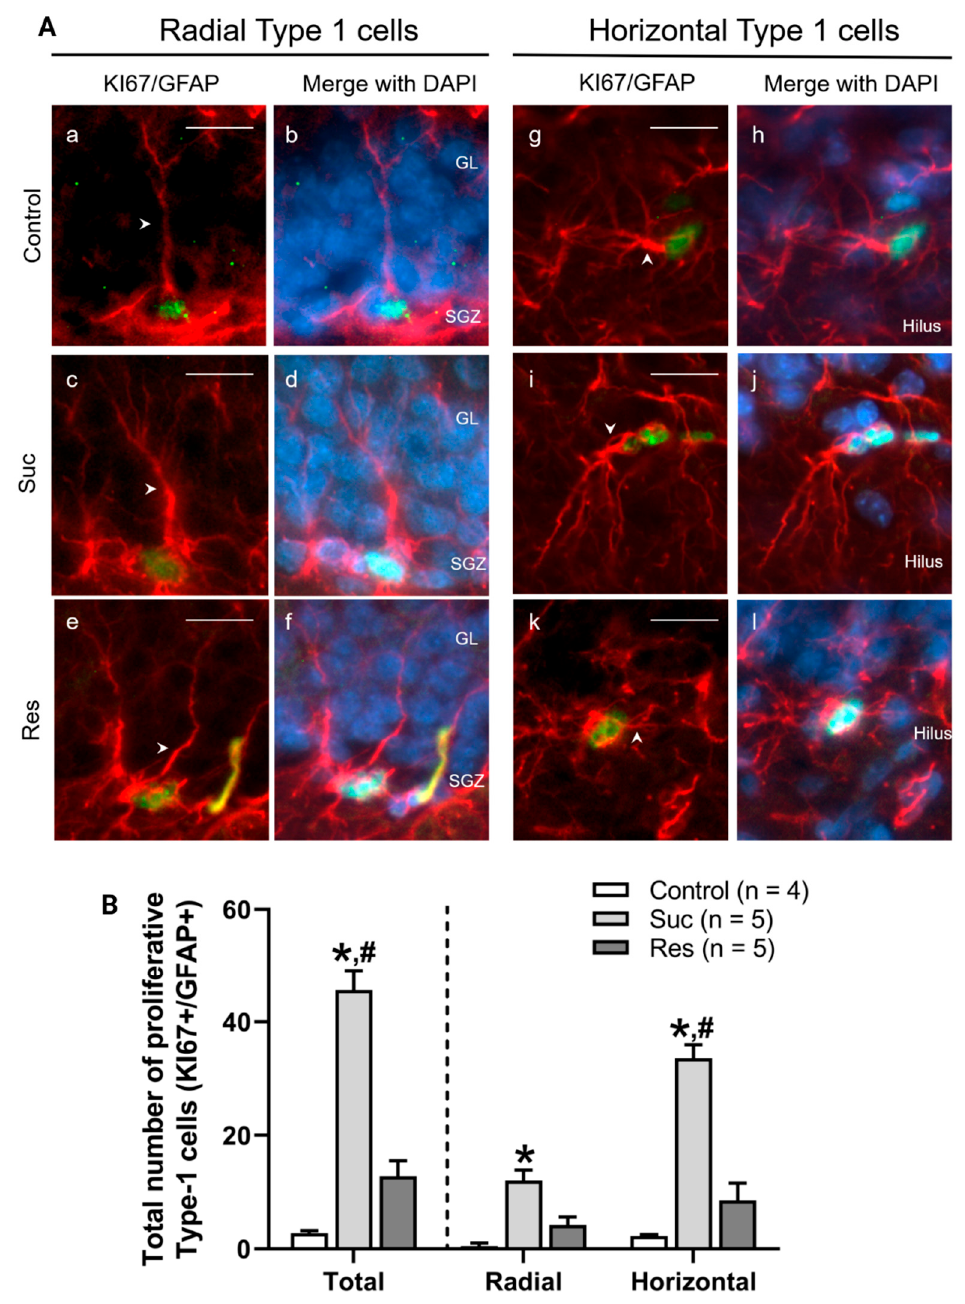
Figure 5. Sucrose consumption during late adolescence increases the number of Radial and Horizontal Type 1 cells in the subgranular zone of ventral dentate gyrus. ( A ) Representative photomicrographs of proliferative Type 1 cells (KI67+/GFAP+) located in the subgranular zone (SGZ) of the ventral dentate gyrus (DG). Left: proliferative Radial Type 1 cells (KI67: green, GFAP: red) and their merge with DAPI (blue) in the SGZ in the control (a,b), Suc (c,d) and Res (e,f) groups. The arrowhead indicates the dendritic arborization showing their radial morphology. Right: proliferative horizontal Type 1 cells and their merge with DAPI in the SGZ in the control (g,h), Suc (i,j) and Res (k,l) groups. The arrowhead indicates the dendritic projections showing their horizontal morphology. ( B ) A cell counting of proliferative Type 1 cells located in the SGZ of the ventral DG. Left: a cell counting of the total number of proliferative Type 1 cells in the SGZ of the control, Suc and Res groups. The number of these cells in the Suc group was higher than those in the control and Res groups. Right: a cell counting of the subpopulations of Type 1 cells (radial and horizontal) in the SGZ of the control, Suc and Res groups. The Suc group showed an increased number of both Radial and Horizontal Type